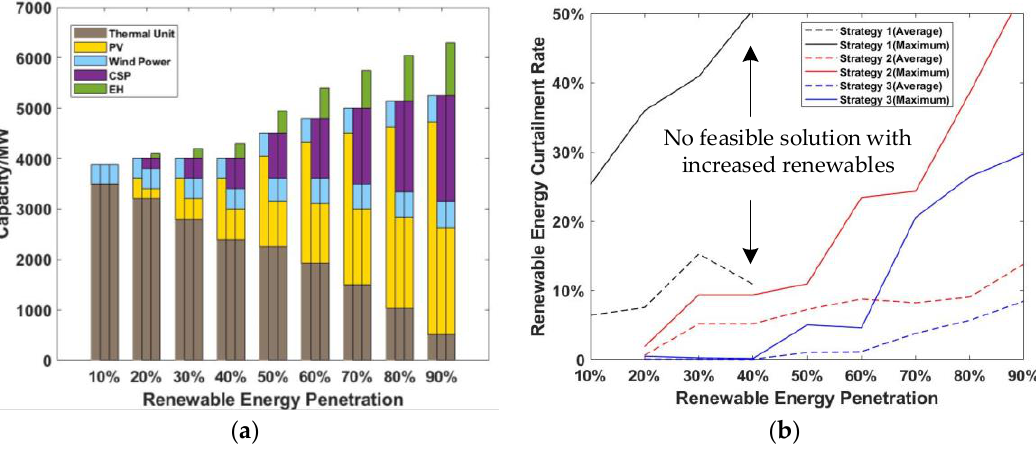
Figure 8. Capacity and curtailment of renewable energy assuming an equal mix of PV and CSP in three strategies, including ( a ) the capacity of generators in different penetrations; ( b ) the renewable energy curtailment rate in different penetrations.